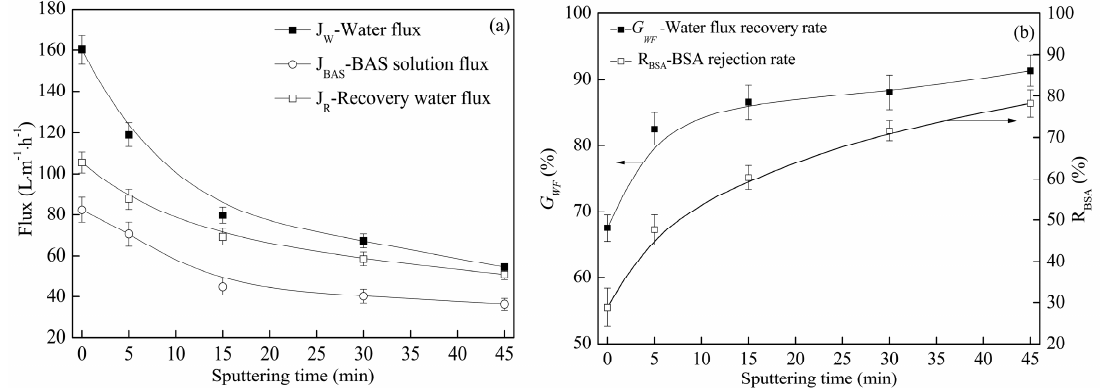
Figure 5. Permeation separation performance (including pure water flux, recovery flux, BSA solution flux, water flux recovery rate, and BSA rejection rate) of the metalized membranes with different sputtering times.